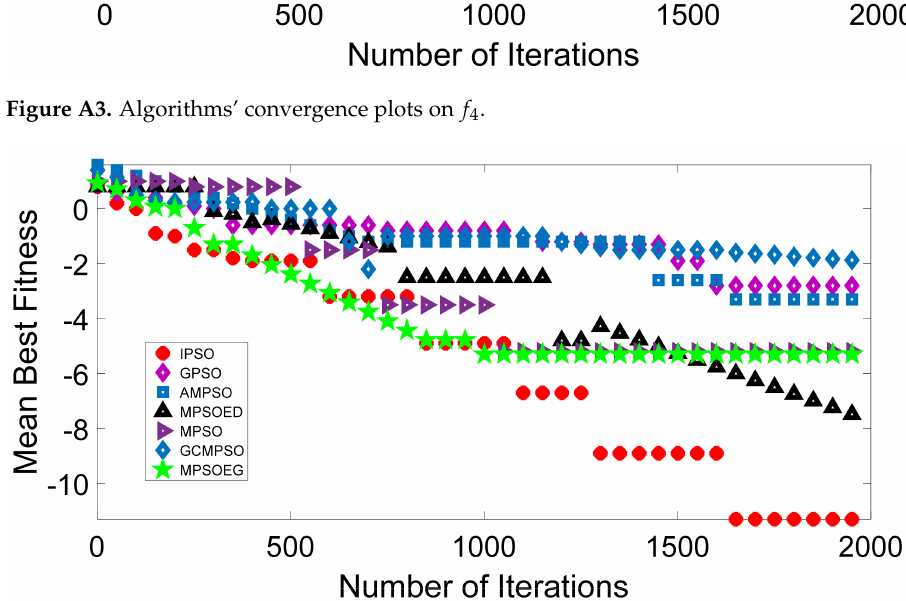
Figure A4. Algorithms’ convergence plots on f 6